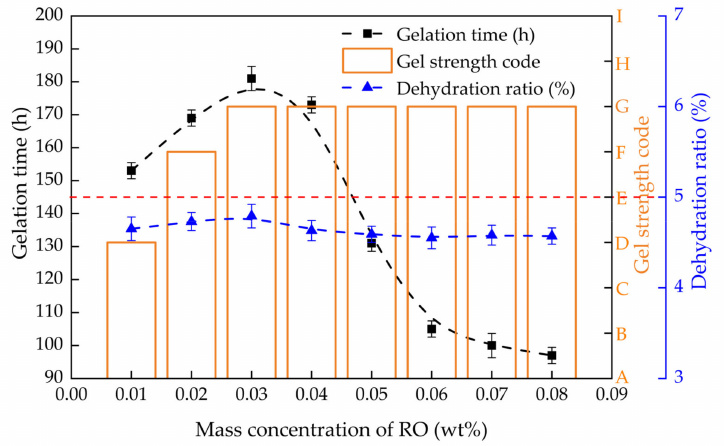
Figure 6. Gelling performance with different concentrations of RO (0.4 wt% PAM + 0.5 wt% HMTA + 0.3 wt%